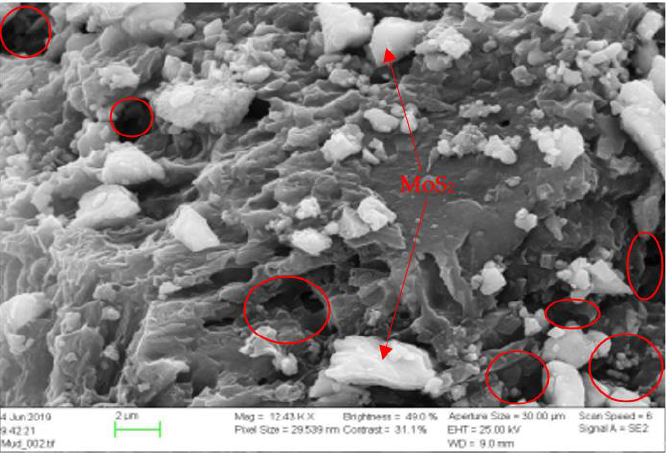
Figure 16. SEM picture of mud cake and MoS 2 deposit (white particles).